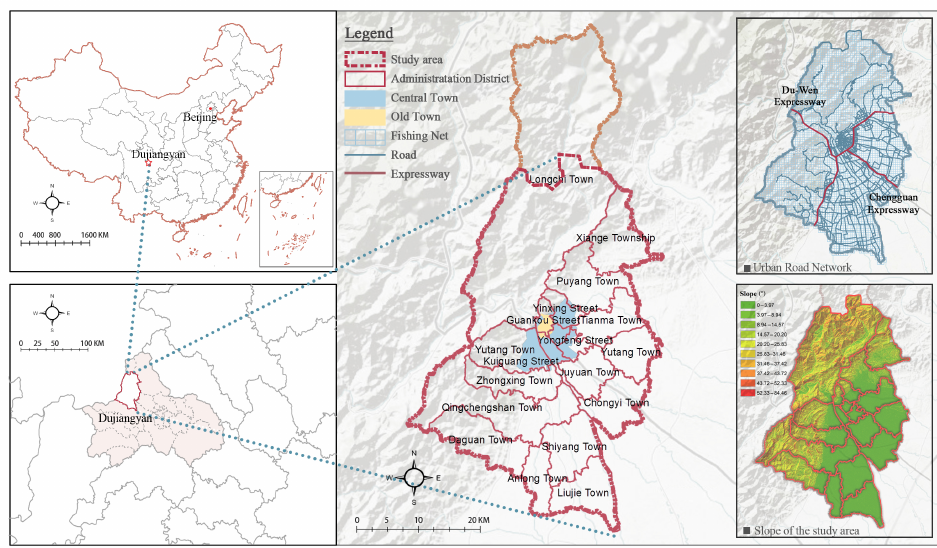
Figure 1. Study area: Dujiangyan,